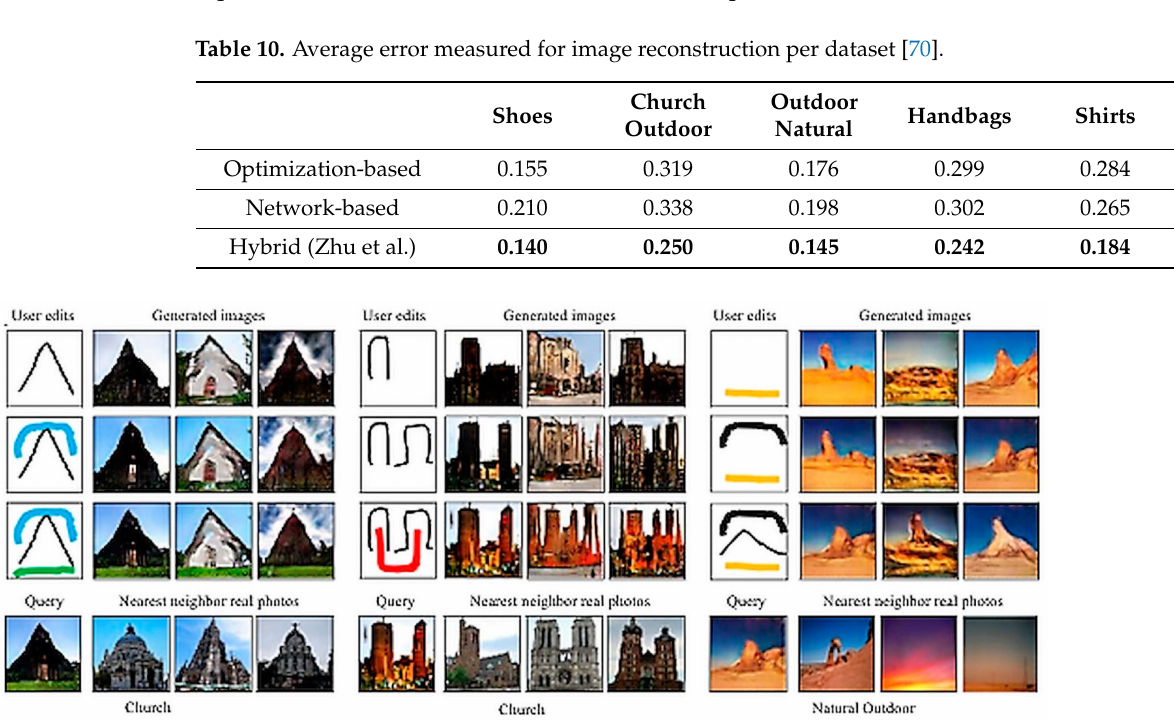
Figure 18. Images generated while performing the task of realistic photo manipulation of color and